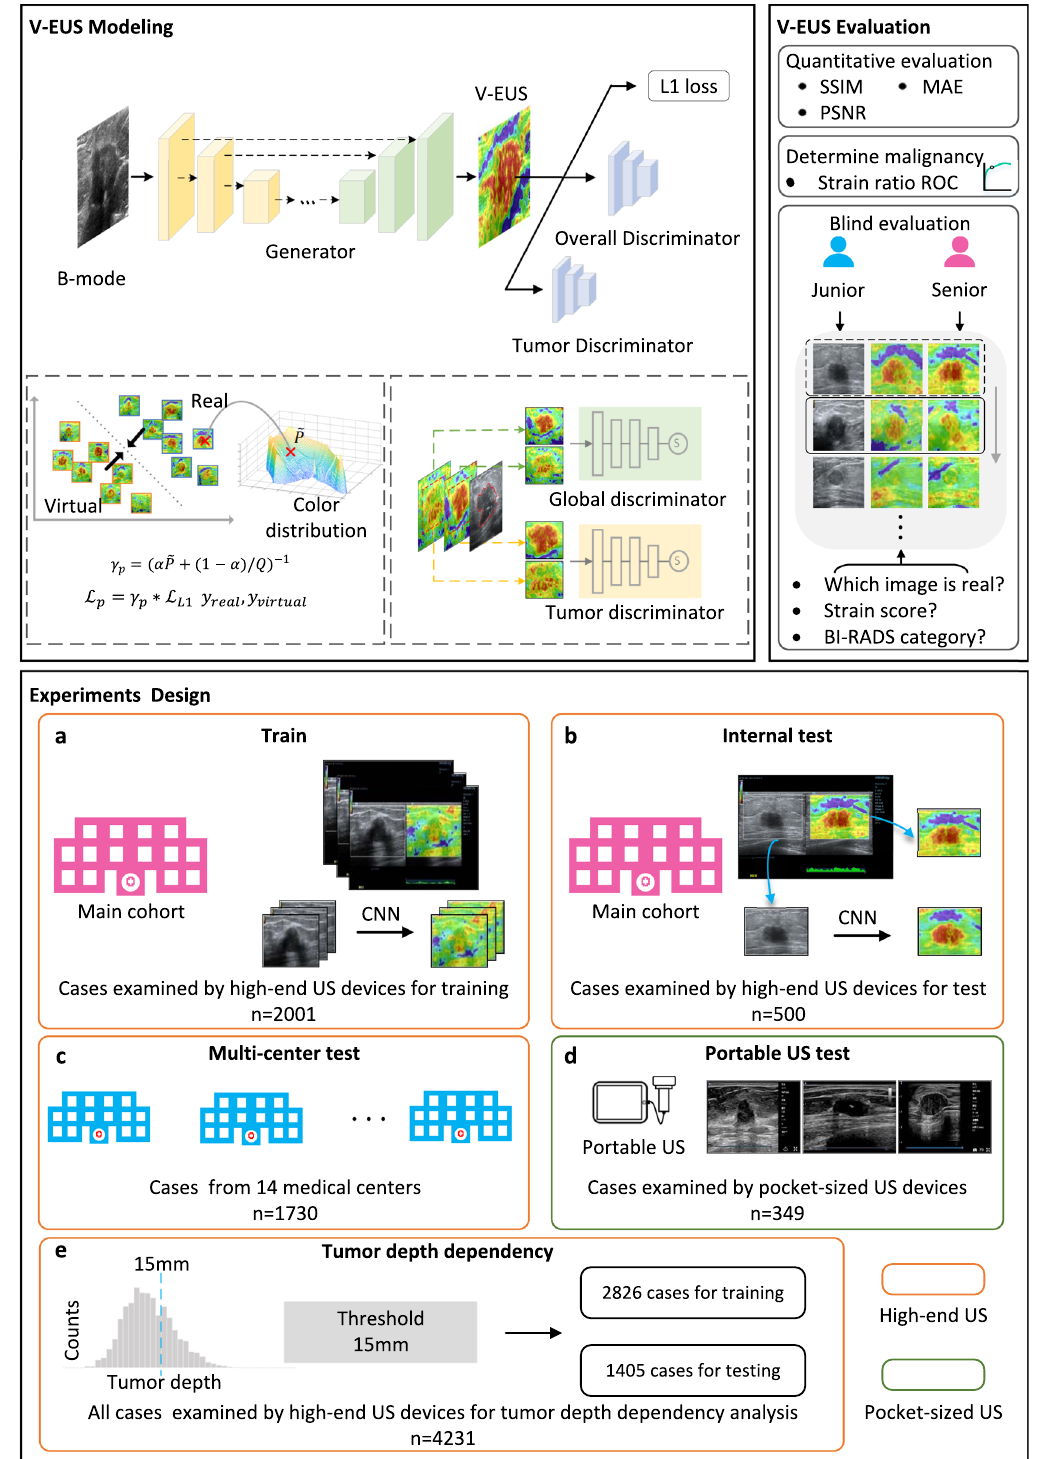
Fig.1|Overviewoftheexperimentalwork fl ow. InV-EUSmodeling,thegenerator takes BUS as input and synthesizes V-EUS, and then the discriminator determines whethertheinputEUSisreal.Acolorrebalancemoduleandatumordiscrimination module are designed to regularize the model. In V-EUS evaluation, the perfor- mance of the model is inspected from three aspects: image quality metrics, determining tumor malignancy, and blind evaluation. We design fi ve experiments in thiswork. a The modelistrained on2001high-quality US images from the main